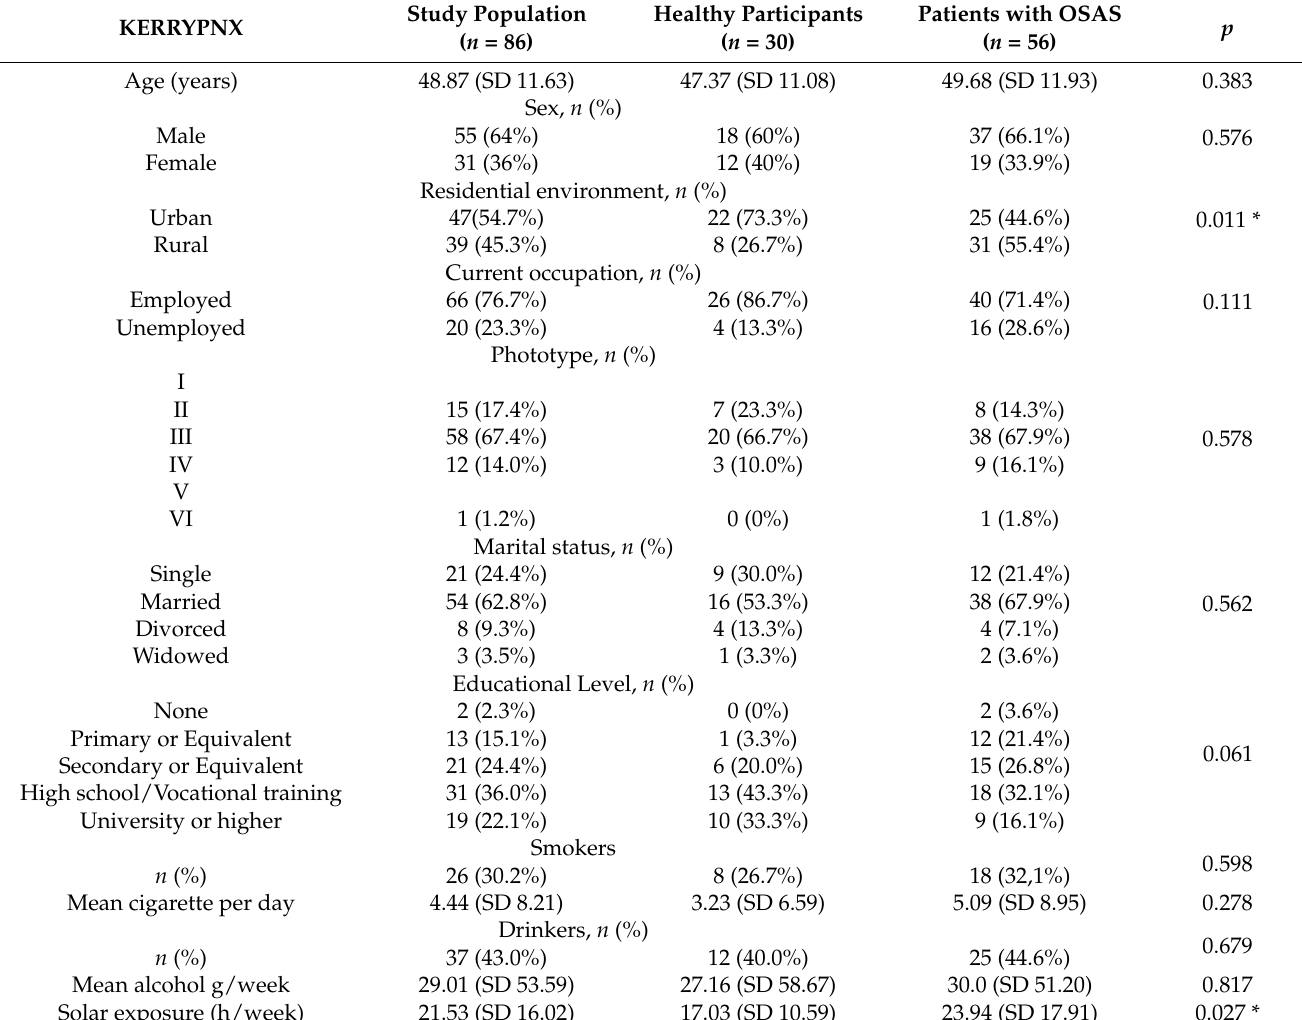
Table 1. Demographic and descriptive characteristics of